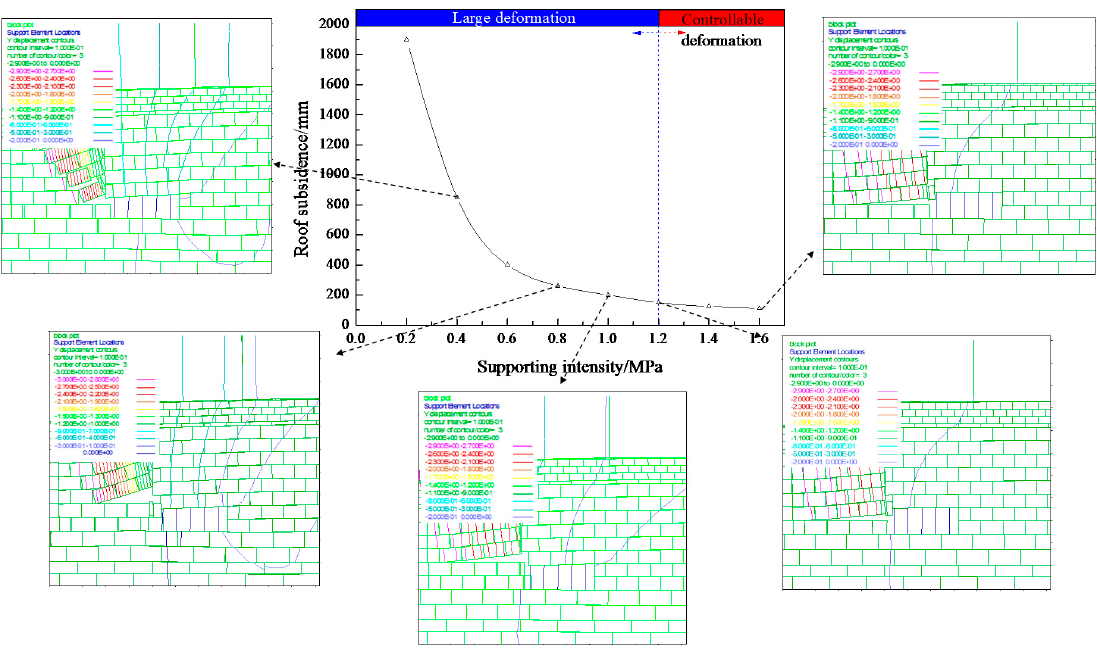
Figure 6. T Roof subsidence under different supporting strength.